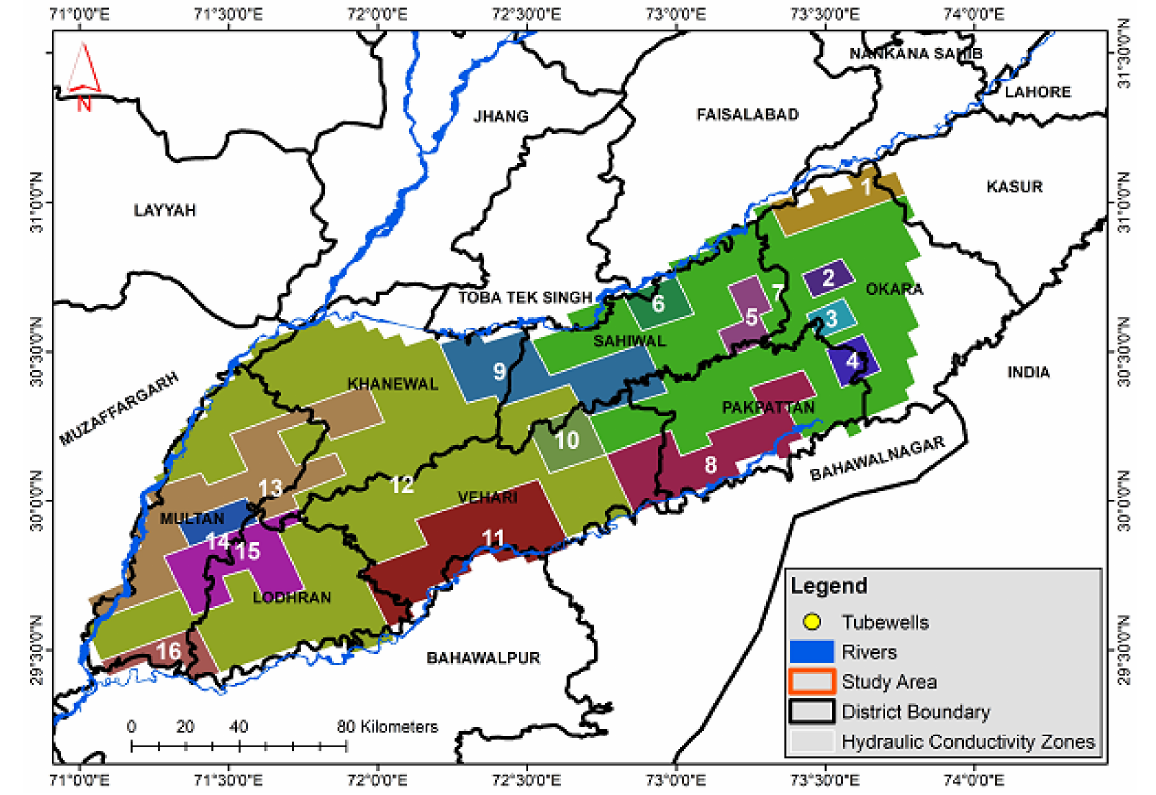
Figure 5. Zonation of hydraulic conductivity (K Lab ) of the aquifer based on laboratory analysis.